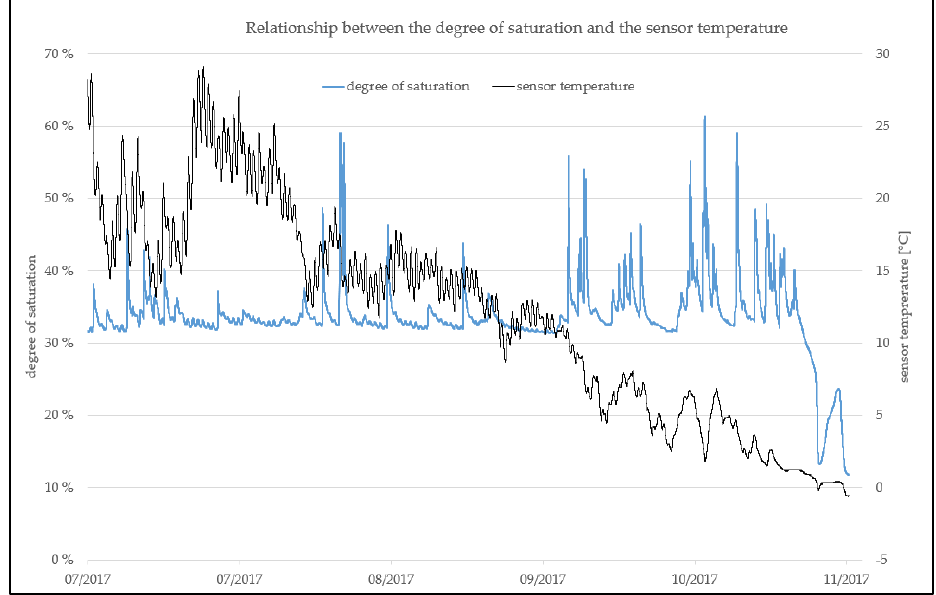
Figure 7. Variation of the degree of saturation within July and November.